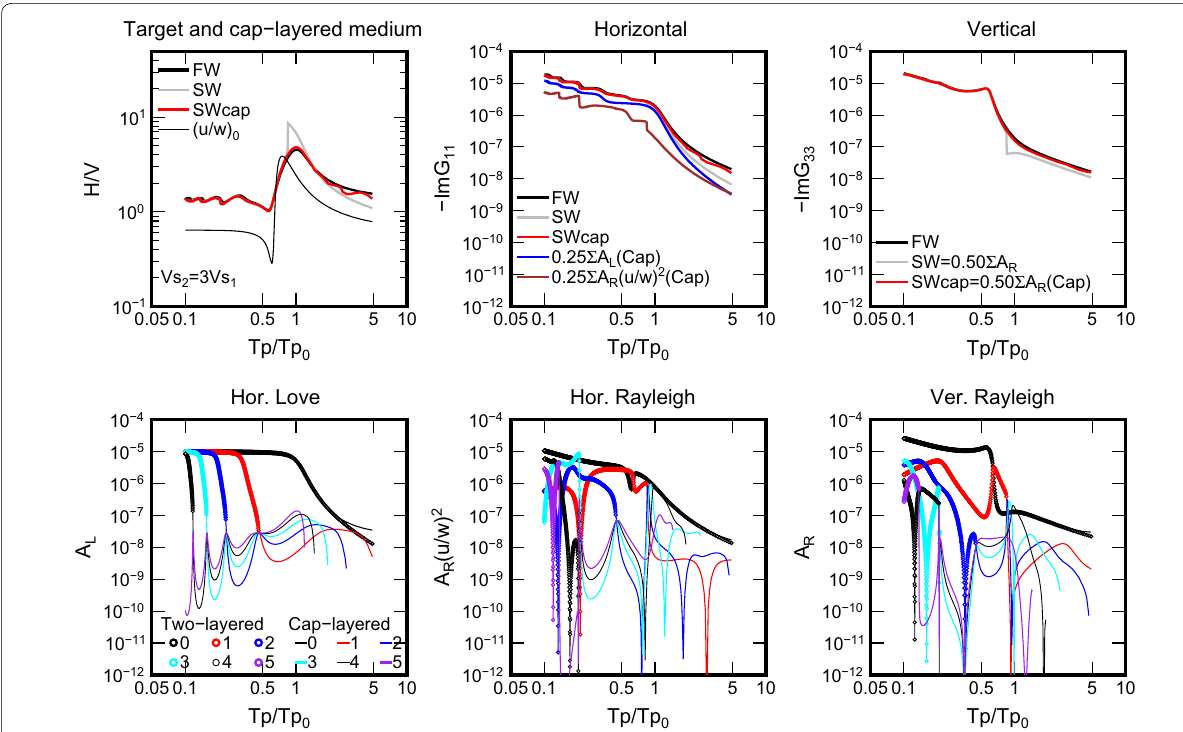
Fig. 2 H / V s, imaginary parts of the Green’s functions, and medium responses of Love and Rayleigh waves of target two‑layered ( V s2 3 V s1 ) and = the corresponding cap‑layered medium ( V sCap 2 V s2 , Depth 10 λ 0 ). Upper left: FW H / V (thick black), SW H / V (gray) and ellipticity (thin black) of = = fundamental mode of Rayleigh waves for target two‑layered medium. Upper middle: imaginary parts of the Green’s functions in the horizontal component for FW (thick black), SW (gray) of target two‑layered medium, and for SW (red), Love waves (blue) and Rayleigh waves (brown) of cap‑layered medium. Upper right: imaginary parts of the Green’s functions in the vertical component for FW (thick black), SW (gray) of target two‑ layered medium, and for SW (red) of cap‑layered medium. Lower left: medium responses (dot) of Love waves of target two‑layered medium and those (solid curves) of cap‑layered medium. Lower middle: horizontal medium responses (dot) of Rayleigh waves of target two‑layered medium and those (solid curves) of cap‑layered medium. Lower right: vertical medium responses (dot) of Rayleigh waves of target two‑layered medium and those (solid curves) of cap‑layered medium. The numbers denote the orders of normal modes of surface waves, e.g., 0 denotes the fundamental mode (black), 1 denotes the first higher mode (red), 2 the second higher mode (blue), 3 the third higher mode (cyan), 4 the fourth higher mode (thin black) and 5 the fifth higher mode